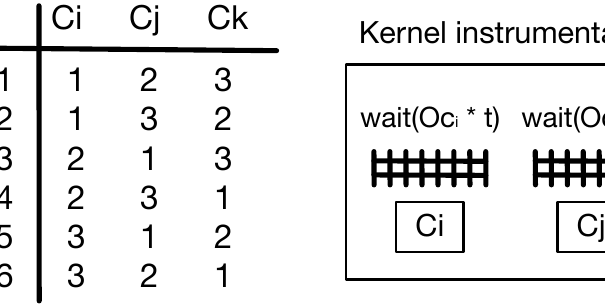
Figure 6. The permutations of the race point’s execution order and kernel instrumentation. The left line denotes the sequence number. The contents of the table are the execution orders of the race points. O c , O c , and O c indicate the execution order of C i , C j , and C k , respectively. t denotes the minimal i j k delay